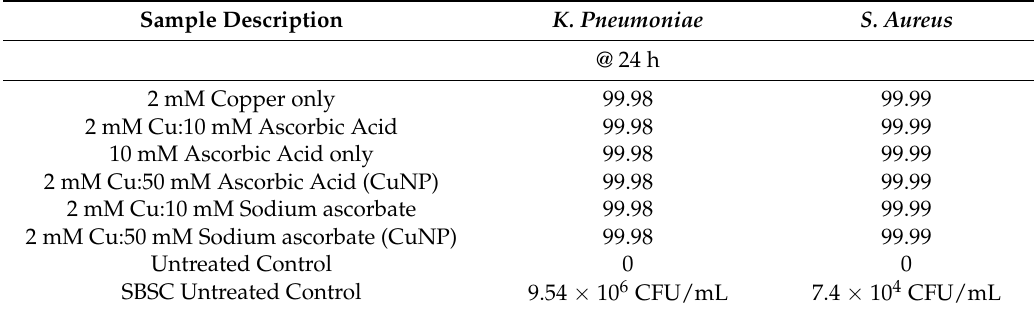
Table 3. Results of Assessment of Formulations in AATCC Test Method 100 for quantitative assessment of antibacterial finishes on textile materials.